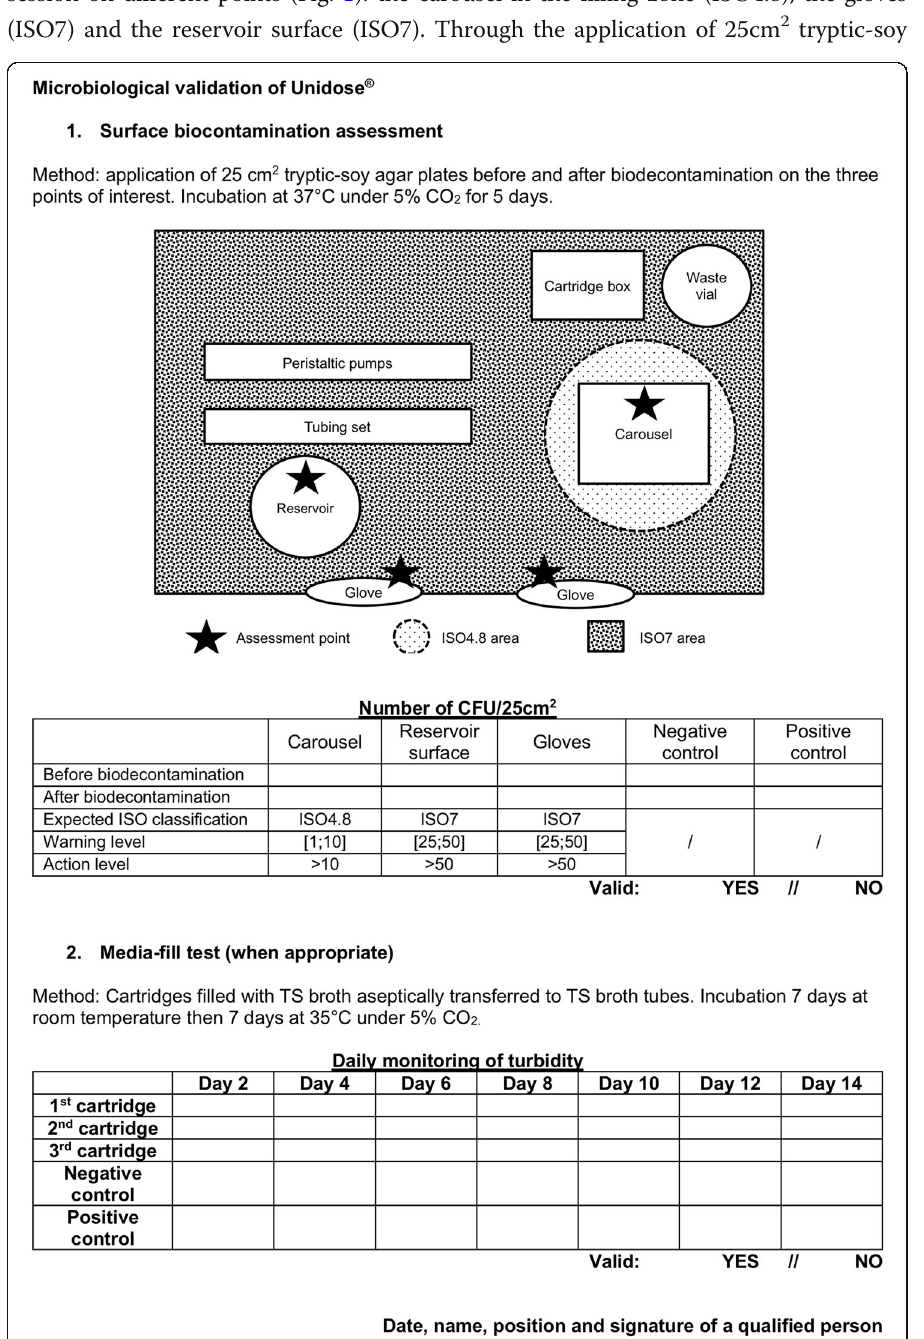
Fig. 1 Datasheet for microbiological qualification of